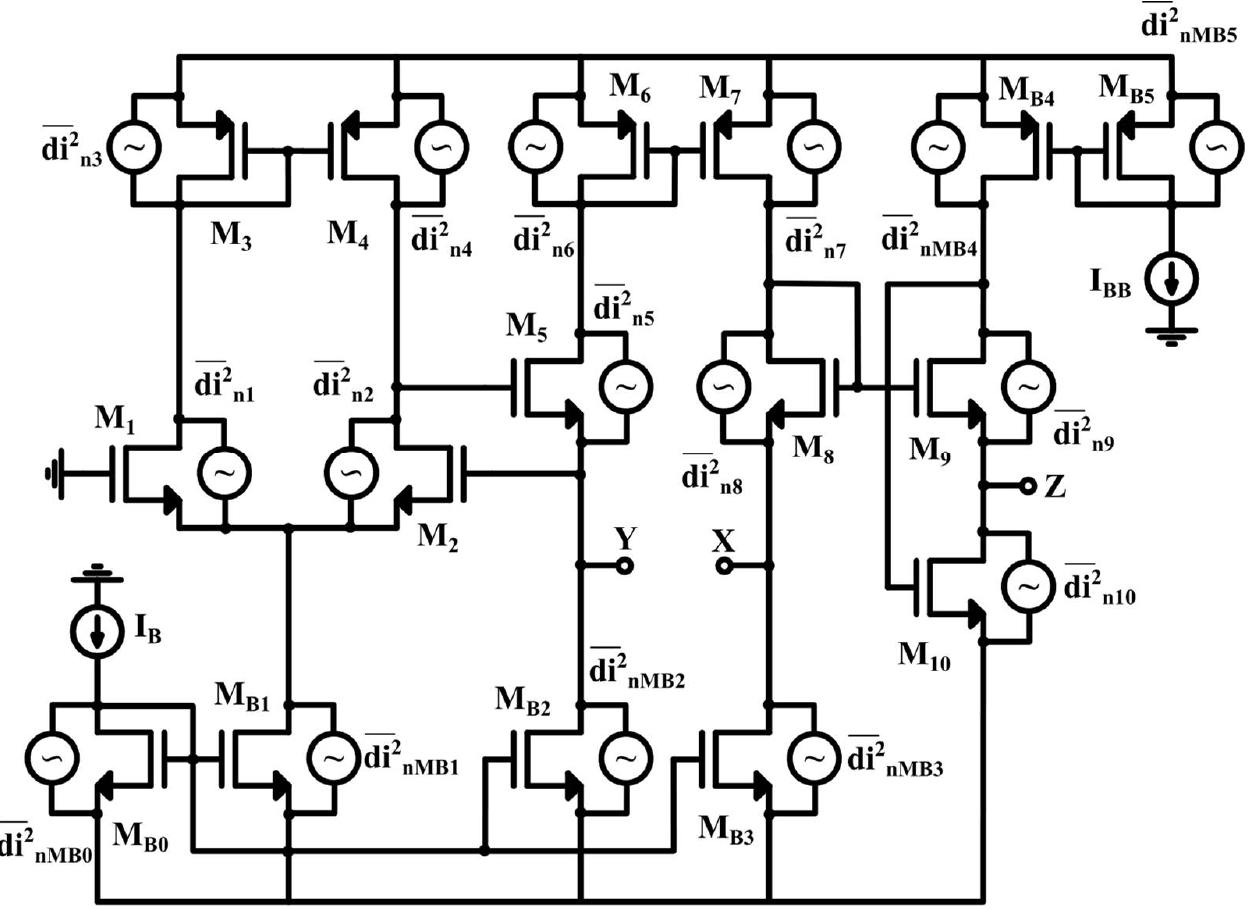
Figure 4. Complete VCII schematic with noise sources [36].